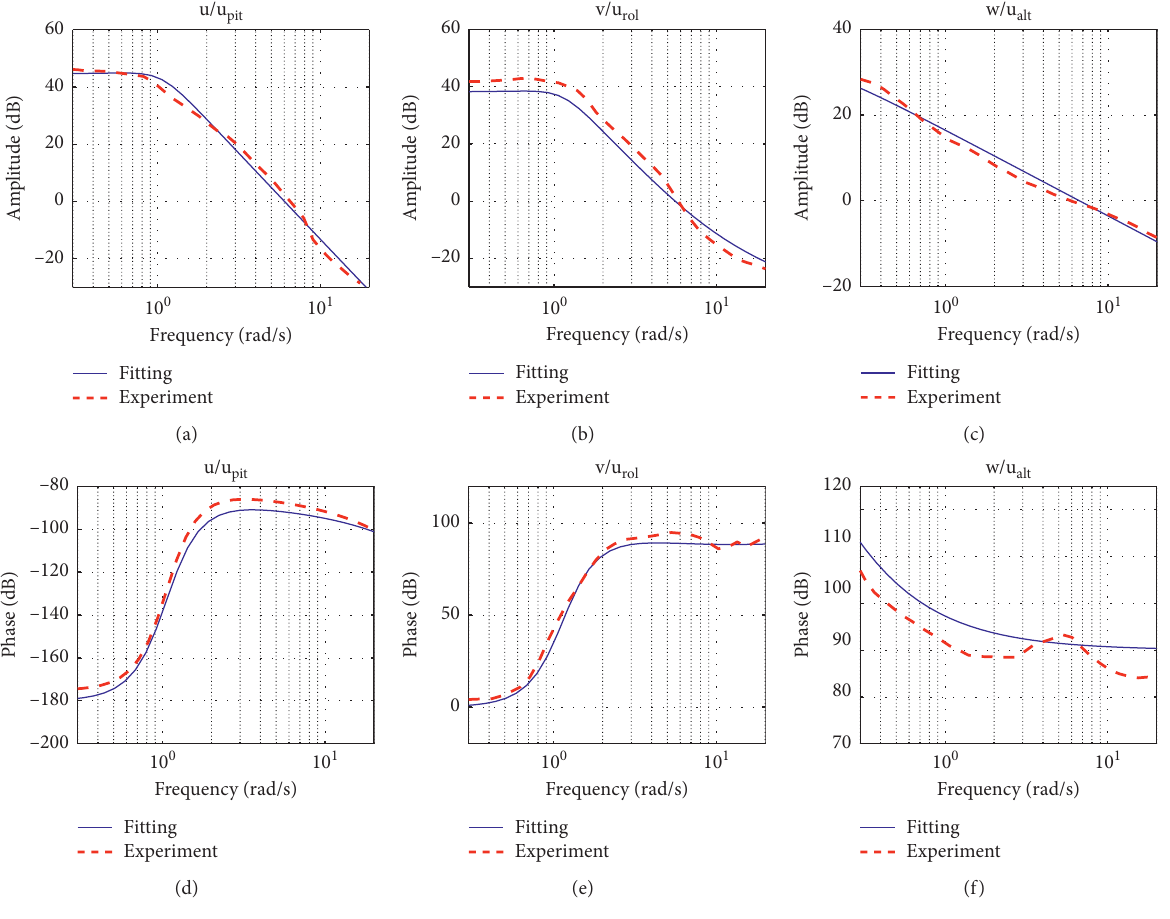
Figure 8: Frequency response identification results of linear